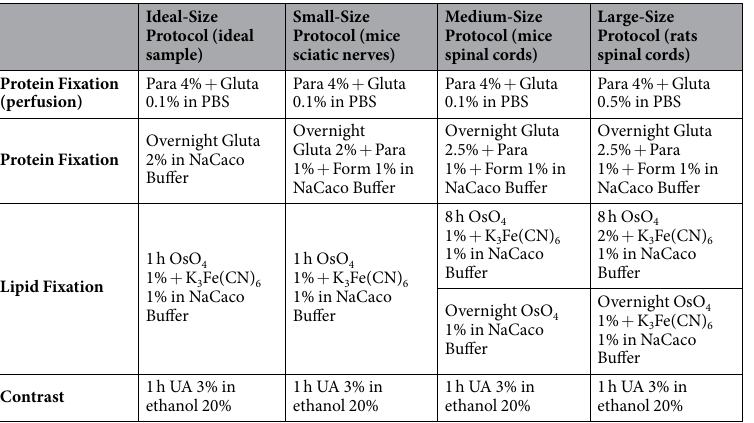
Table 1. The specific embedding procedure for each sample size. The table reports all the embedding size- dependent procedures we have specifically modified for the best result of our correlative analysis. Abbreviations: Gluta = Glutaraldehyde/Para = Paraformaldehyde/Form = Formaldehyde/NaCaco Buffer = Sodium